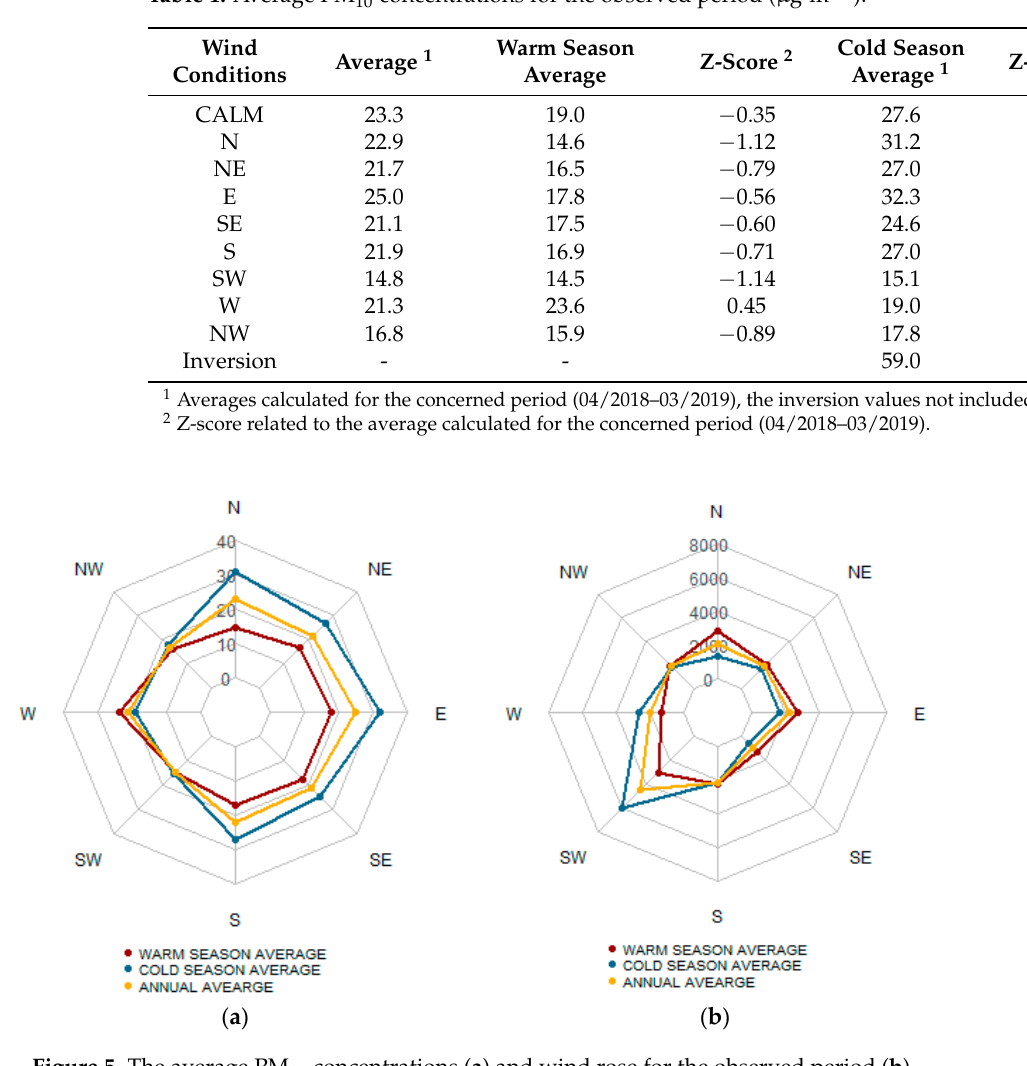
Figure 5. The average PM 10 concentrations ( a ) and wind rose for the observed period ( b ).